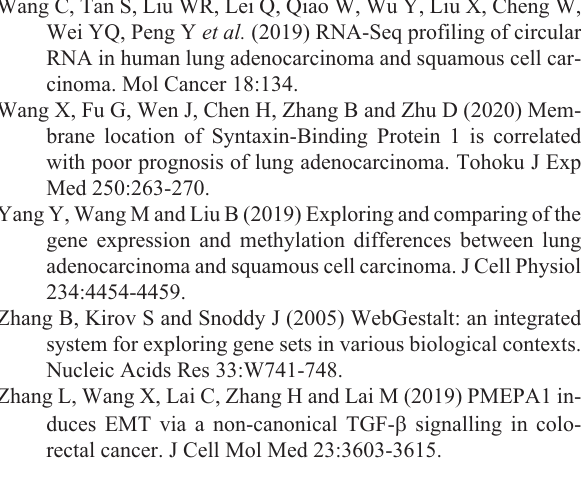
Table S2 - The list of differentially expressed mRNAs be- tween LUSC and LUAD. Table S3 - The list of differentially expressed circRNAs be- tween LUSC and LUAD. Table S4 - The differentially expressed genes related